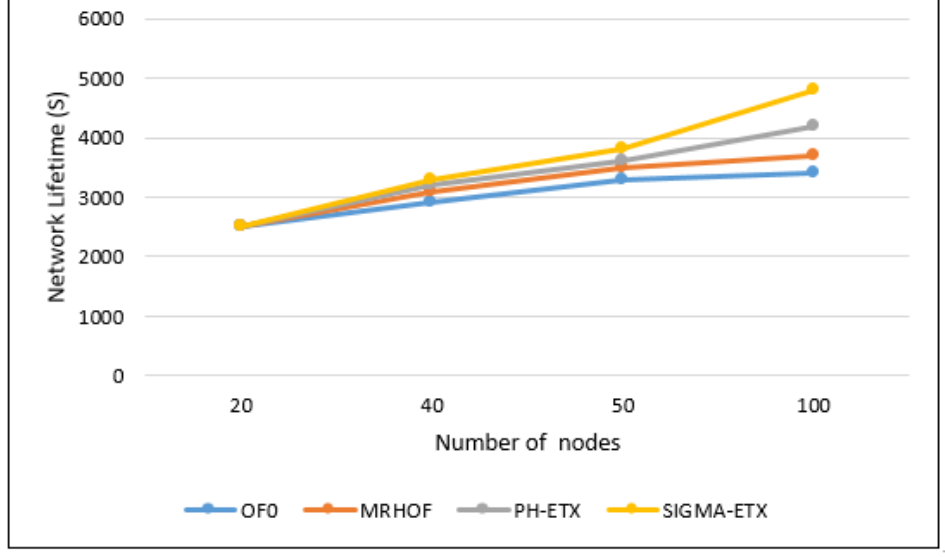
Figure 16. Network lifetime.